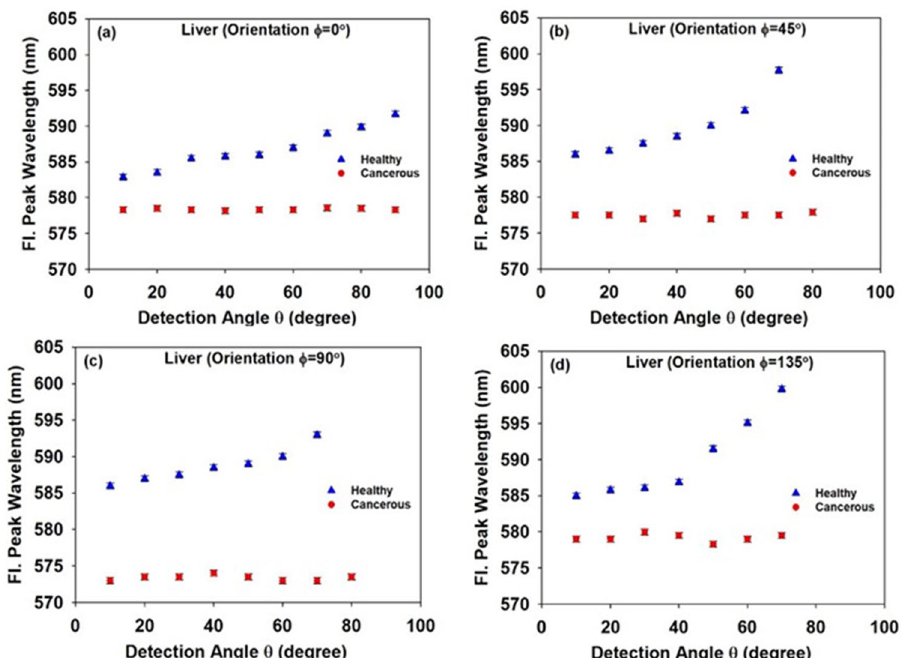
Figure 7. Wavelength of the LIF peak (λ max ) in terms of detection angle ( θ ) for healthy and cancerous liver tissues at different orientations: (a) φ = 0°, (b) φ = 45°, (c) φ = 90°, and (d) φ =